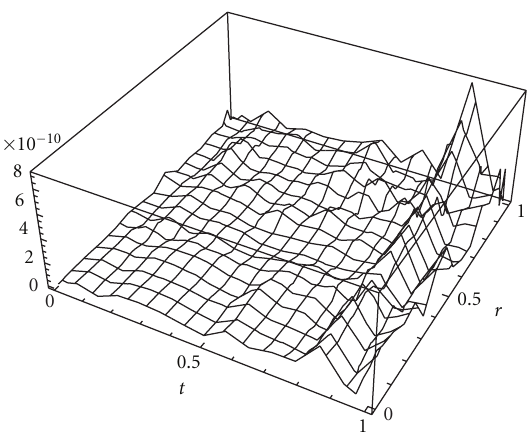
Figure 25: Contour plot of ( ∂ 3 /∂t 3 ) G